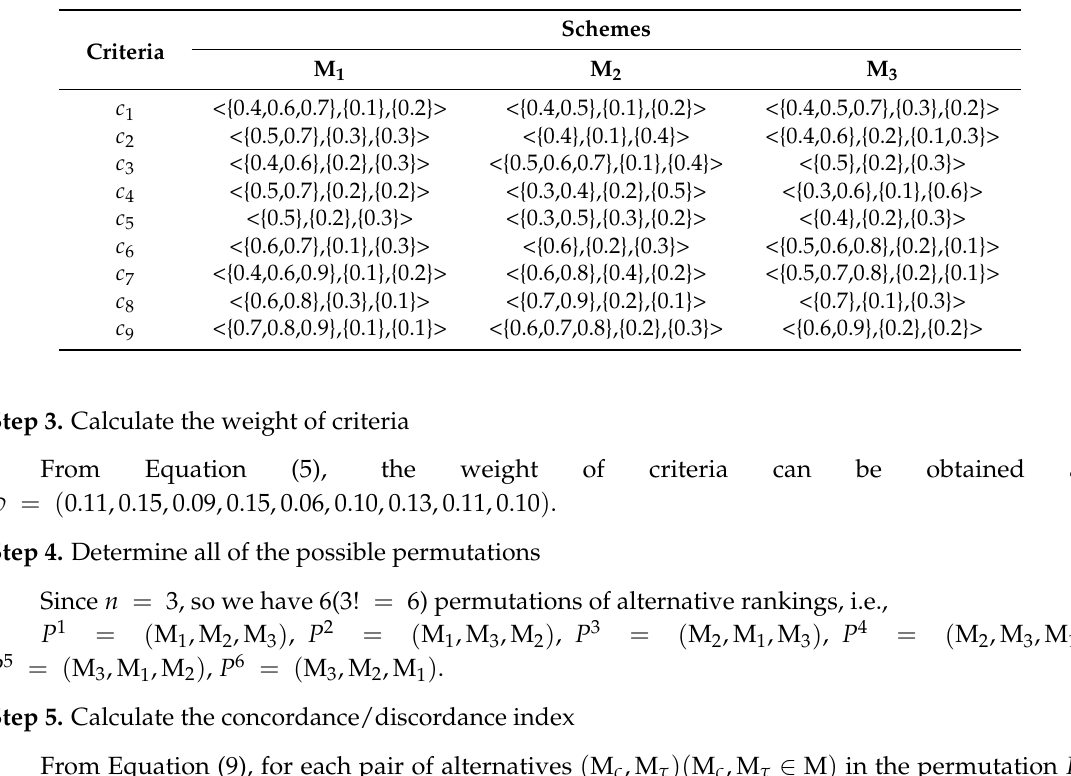
Table 2. Normalized decision